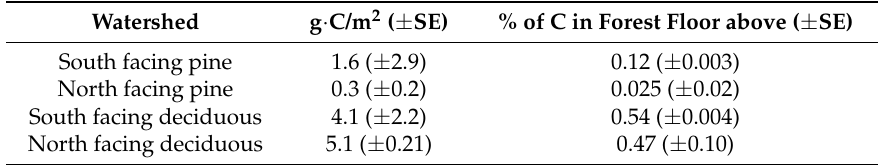
Table 6. Downward fluxes of C in fine particles from the bottom net. Data show that there was no large flux of fine particulate C into the mineral